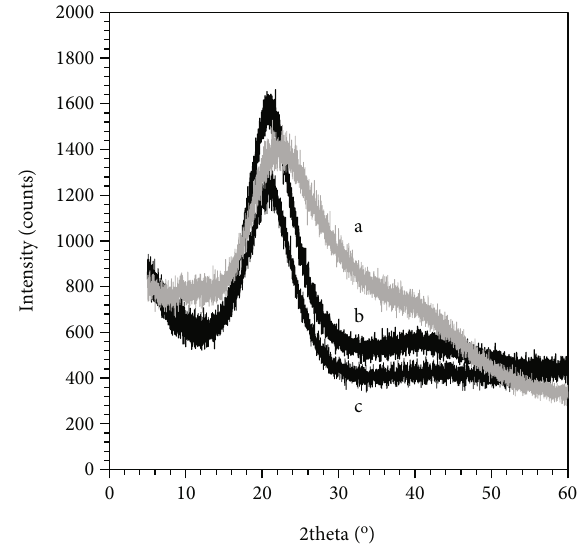
Figure 6: DSC thermograms of di ff erent freeze-dried samples. Figure